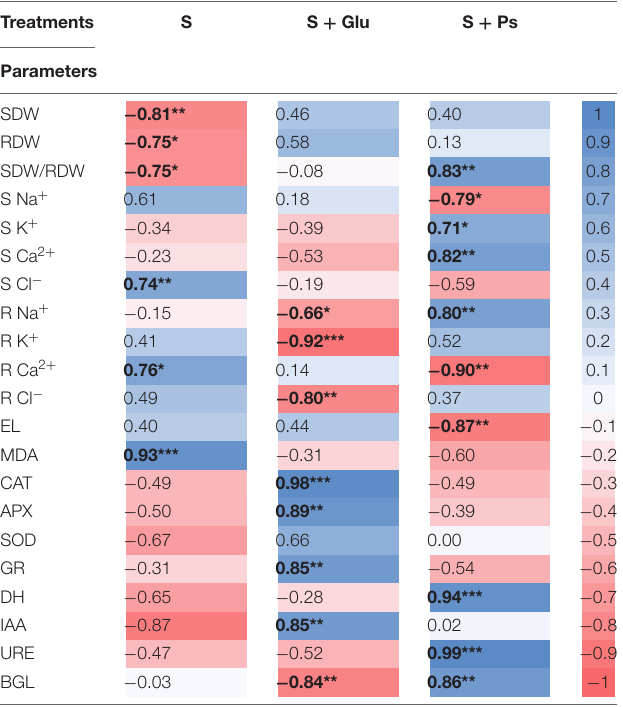
TABLE 2 | Pearson’s correlation matrix analyzing S, S + Glu, and S + Ps treatments and different studied parameters.